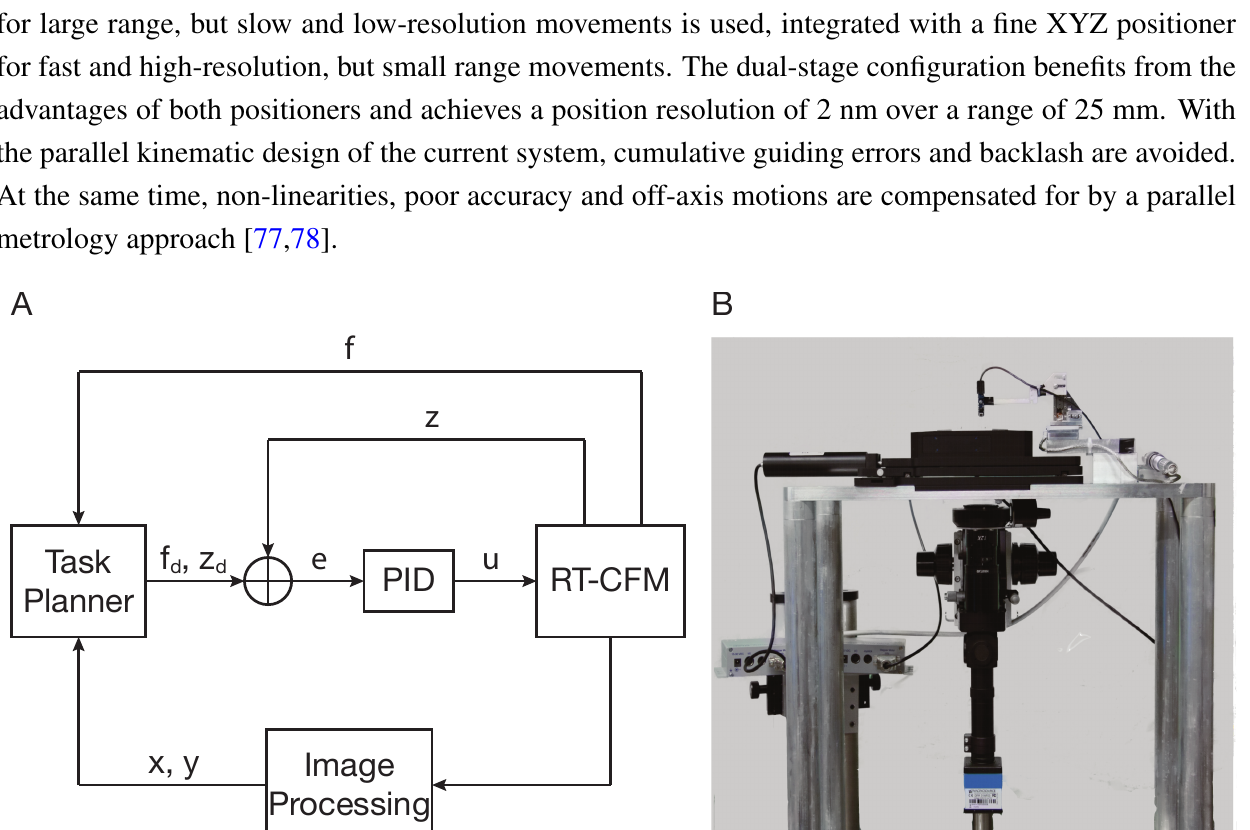
, z are the desired values of force d d